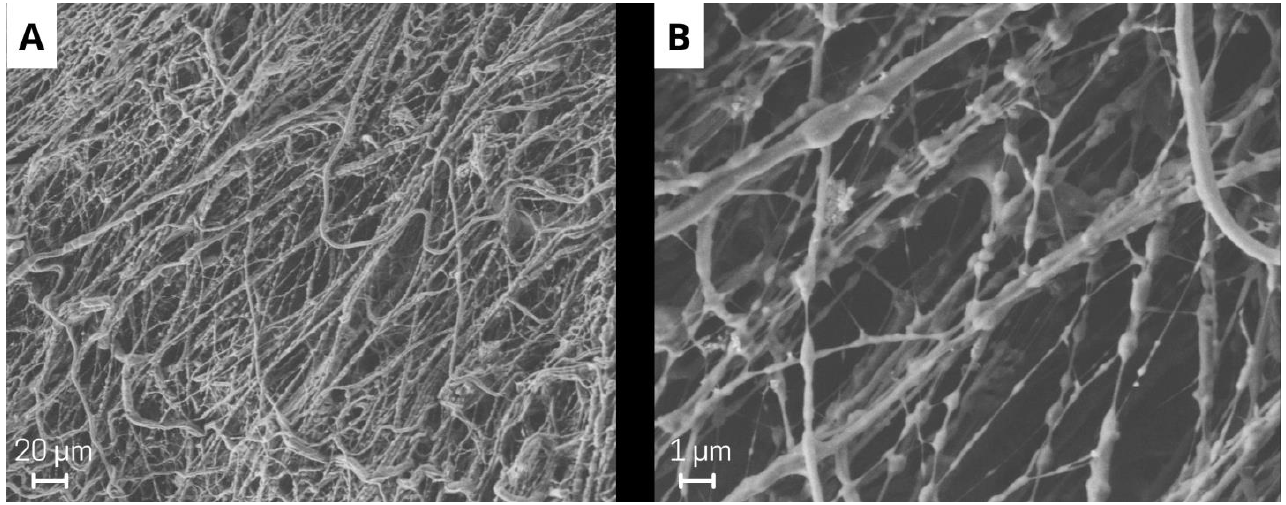
Figure 1. FE- SEM images of electrospinning jussara nanofibers, scale bars 20 μm ( A ) and 1 μm ( B ). Figure 1. FE-SEM images of electrospinning jussara nanofibers, scale bars 20 µ m ( A ) and 1 µ m ( B